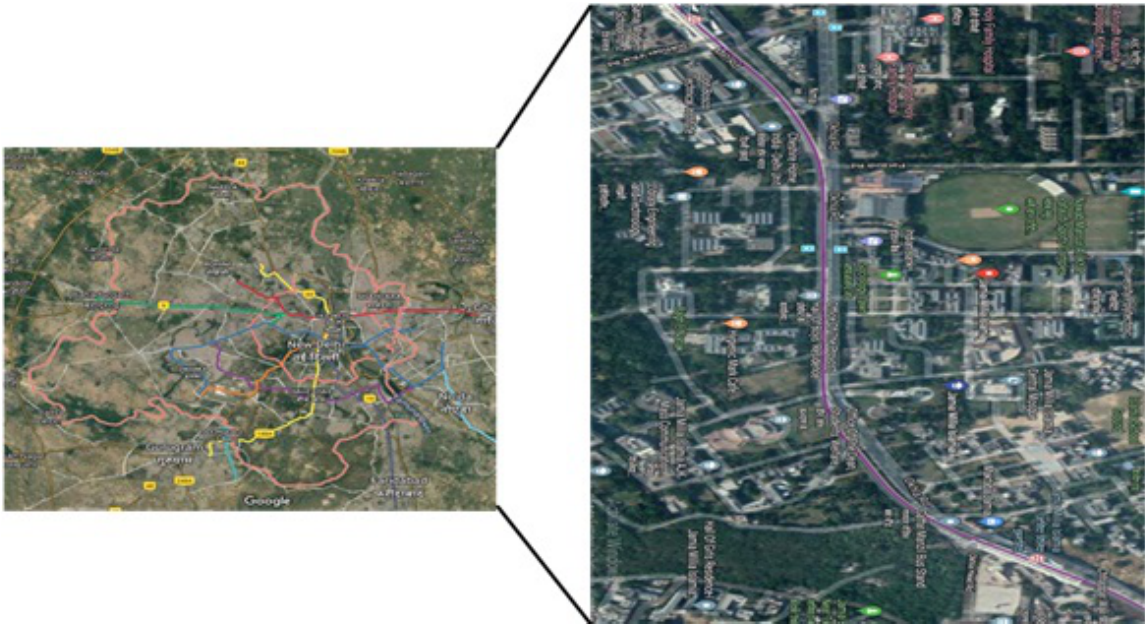
Figure 1: Study area for noise monitoring and 3D mapping (Source: Google map)